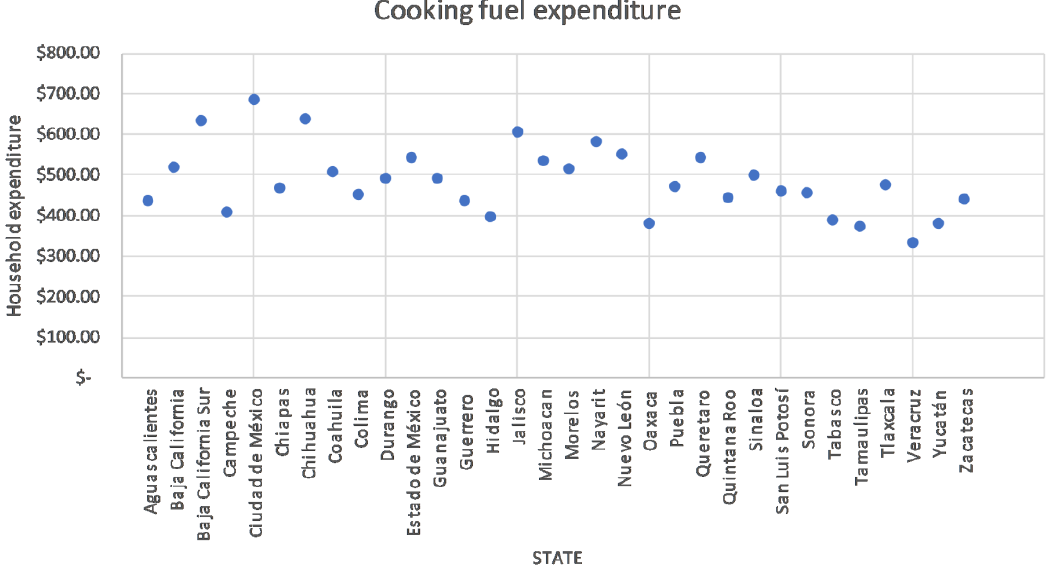
Figure 3. Average monthly cooking fuel expenditure per household in pesos, by State. Source ENCEVI, INEGI.